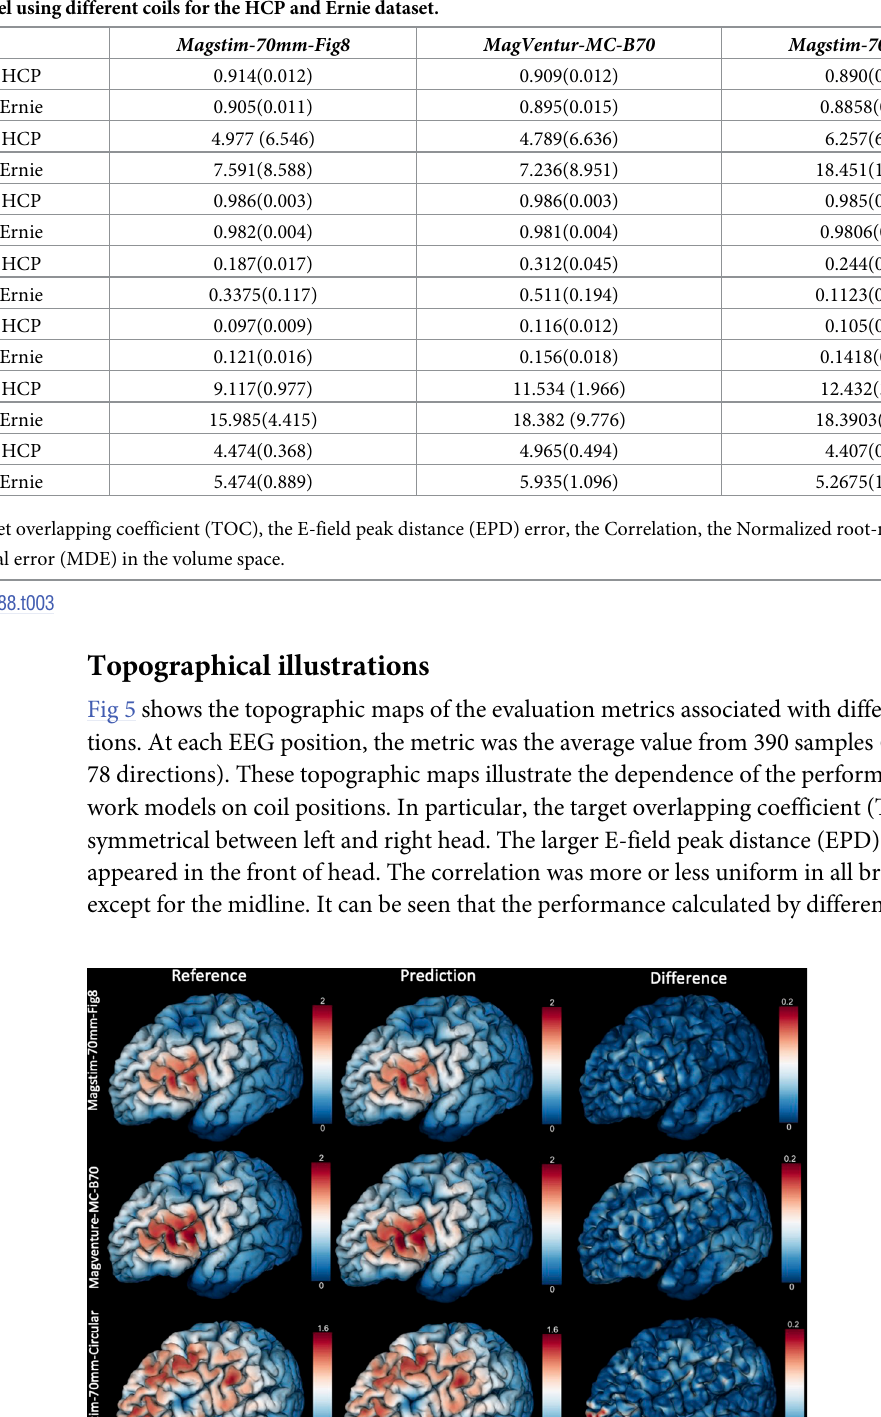
Table 3. Performance of the C-60 model using different coils for the HCP and Ernie dataset.